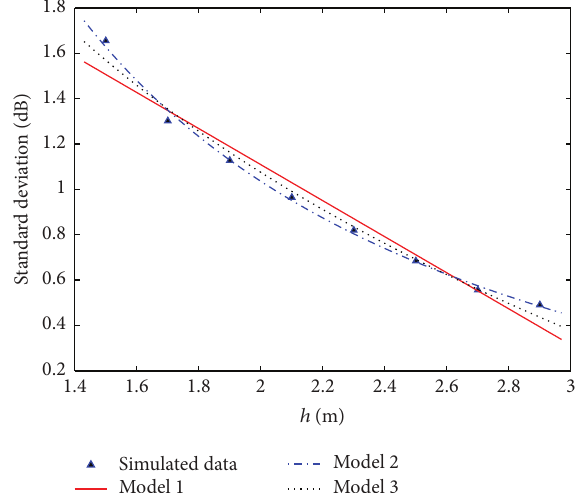
Figure 14: The fit curves of three models versus Tx height ℎ .